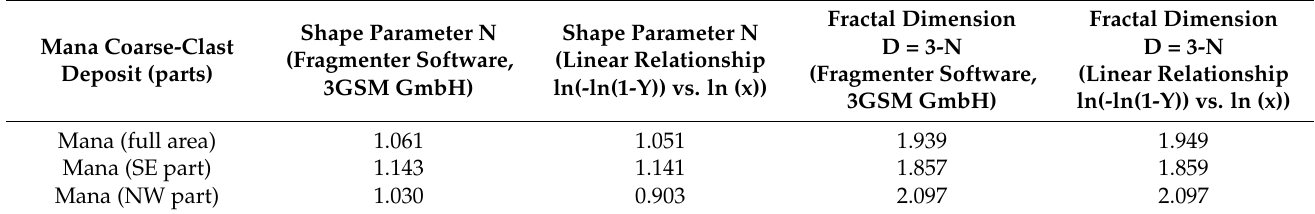
Figure 8. ( a ) Linear regression for empirical fragment size data; shape parameter for entire area N = 1.051, for proximal (SE) part N = 1.141 and for distal (NW) part N = 0.903 ( b ) The R-R cumulative fragment size distribution for the entire area, as well as for the proximal (SE) and distal (NW) parts. Table 2. Shape parameter and fractal dimension for the entire analyzed Mana deposit area, as well as for the proximal (SE) and distal (NW)